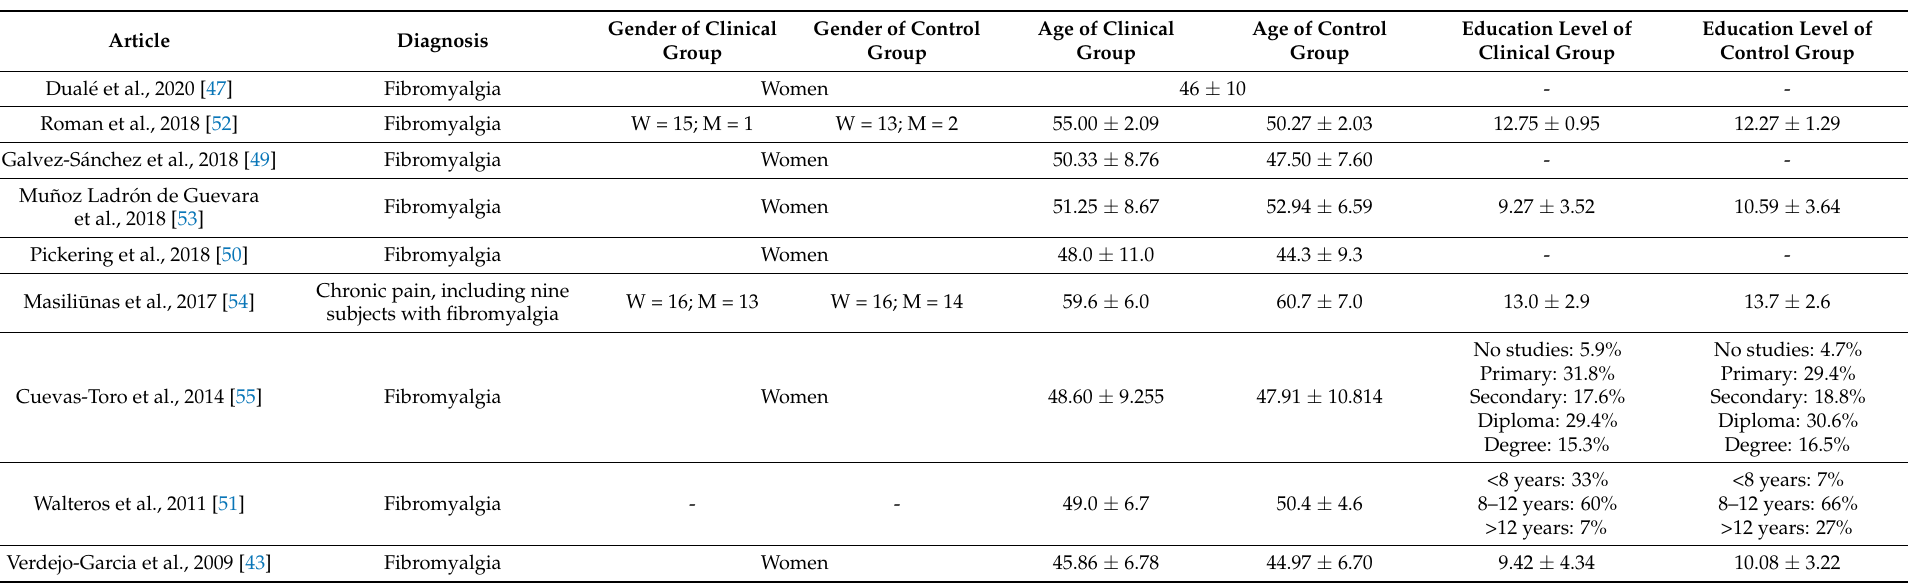
Table 1. Demographic details of subjects included in the reviewed studies. The numerical data are expressed as mean ± SD or as percentages